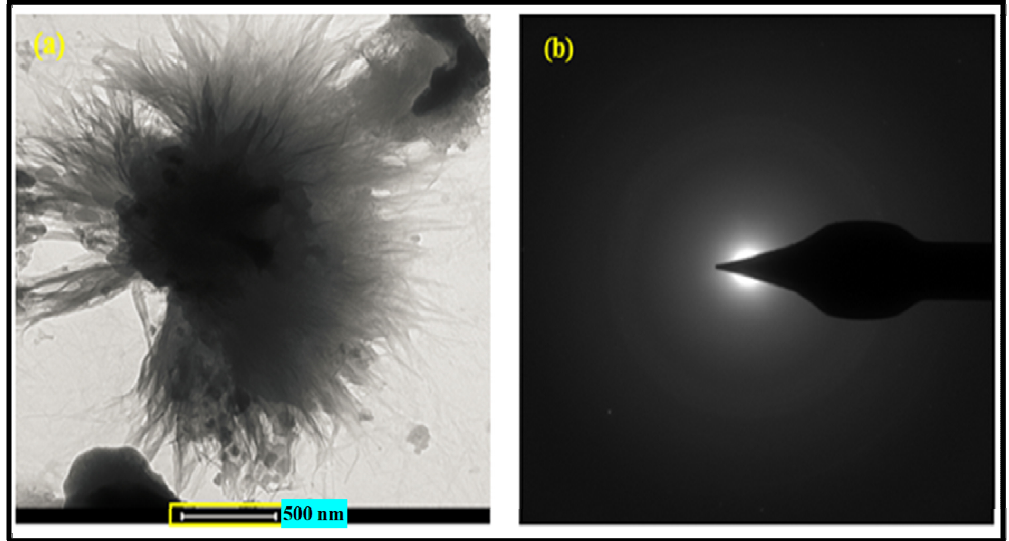
Fig. 3. (a) Showing Transmission electron microscopy of Mg(OH)